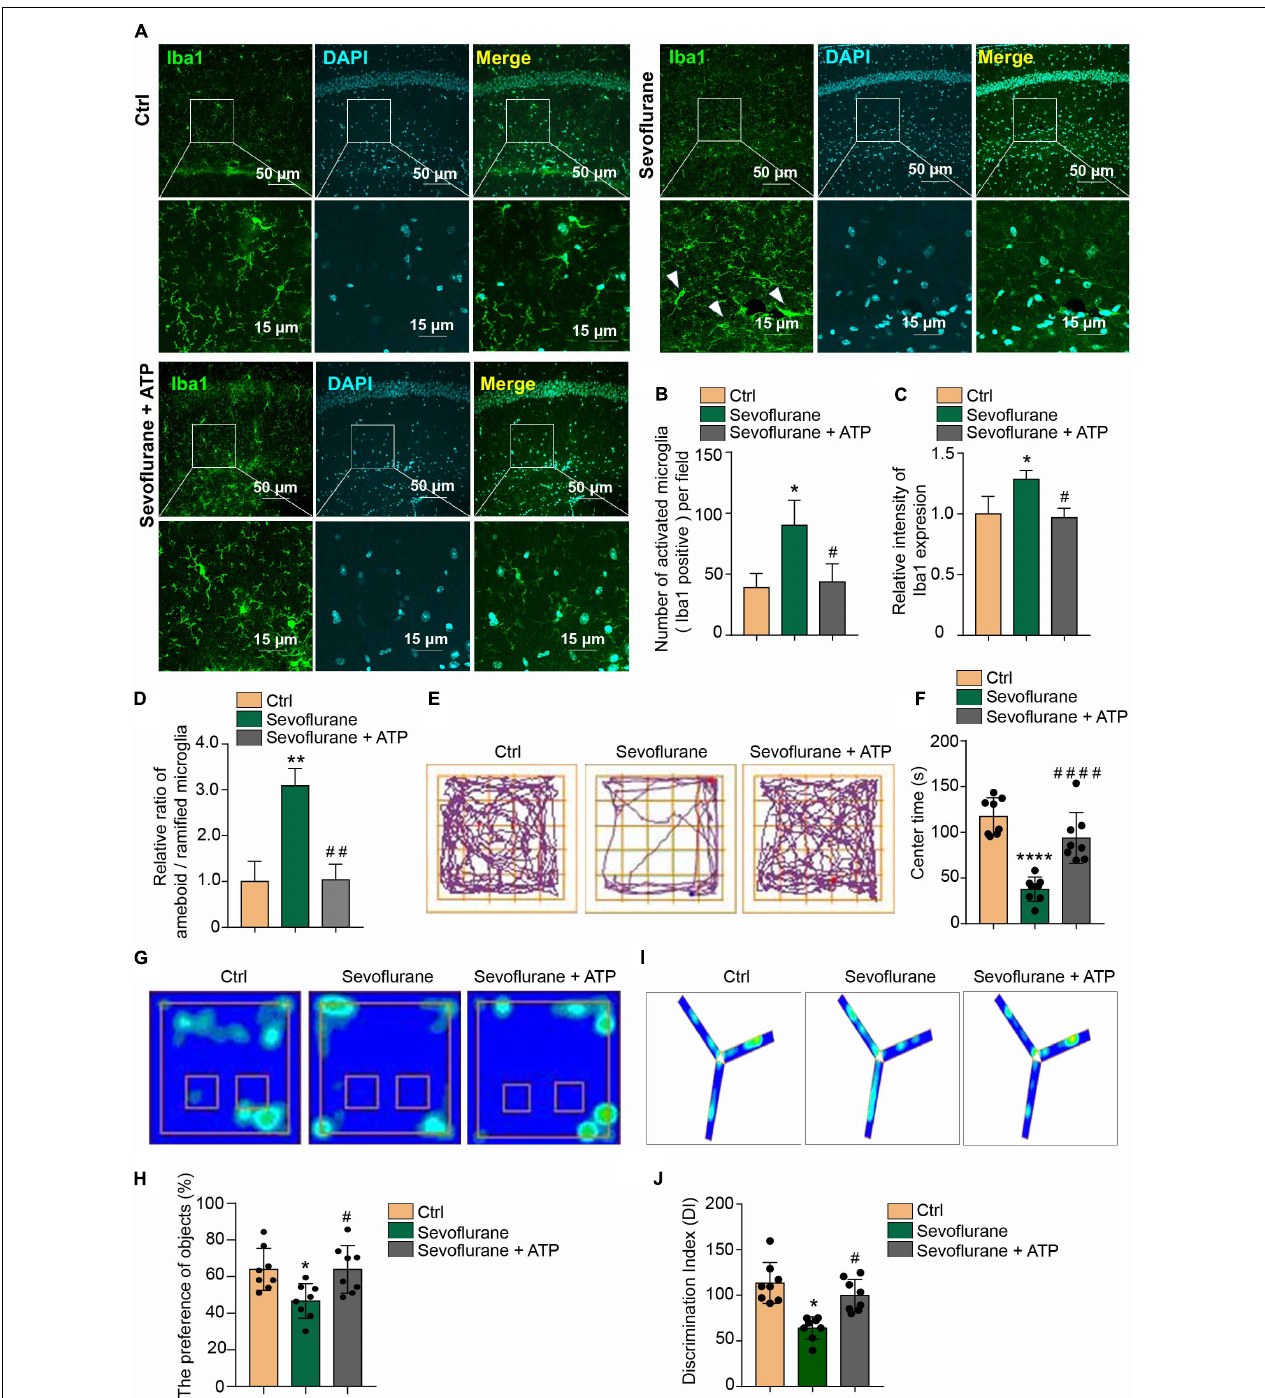
FIGURE 5 | Attenuation of anxious and short-term memory behaviors by acute ATP treatment in POD mice. (A) Intraperitoneal (i.p.) injection of 2 mg/kg ATP ameliorated the 3% sevoflurane treatment inducing microglia activation as detected by Iba1 immunofluorescence staining in hippocampal tissue. The scale bar indicates 50 (upper row) and 15 µ m (lower row), respectively. (B) ATP supplementary inhibited the increase of quantification of Iba1 + cell numbers and (C) intensity in sevoflurane-treated mice. (D) The ratio between amoeboid/ramified was also restored to be similar with the control groups by ATP supplementary in sevoflurane treatment mice. (E,F) Intraperitoneal (i.p.) injection of 2 mg/kg ATP ameliorated anxious behaviors in sevoflurane treatment POD mice, as detected by the open field test. (G,H) Novel object recognition and (I,J) Y-maze tests indicated that intraperitoneal (i.p.) injection of 2 mg/kg ATP ameliorated short-term memory impairment in the POD mouse model. One-way ANOVA with repeated measurement and post hoc analysis with Bonferroni were used to analyze the data presented in panels (B–D,F,H,J) . The data shown are the means ± SD [ n = 3 in (B–D) n = 8 in (E–J) ]. For all data, * and # indicate p < 0.05, ** and ## indicate p < 0.01, and *** and ### indicate p <